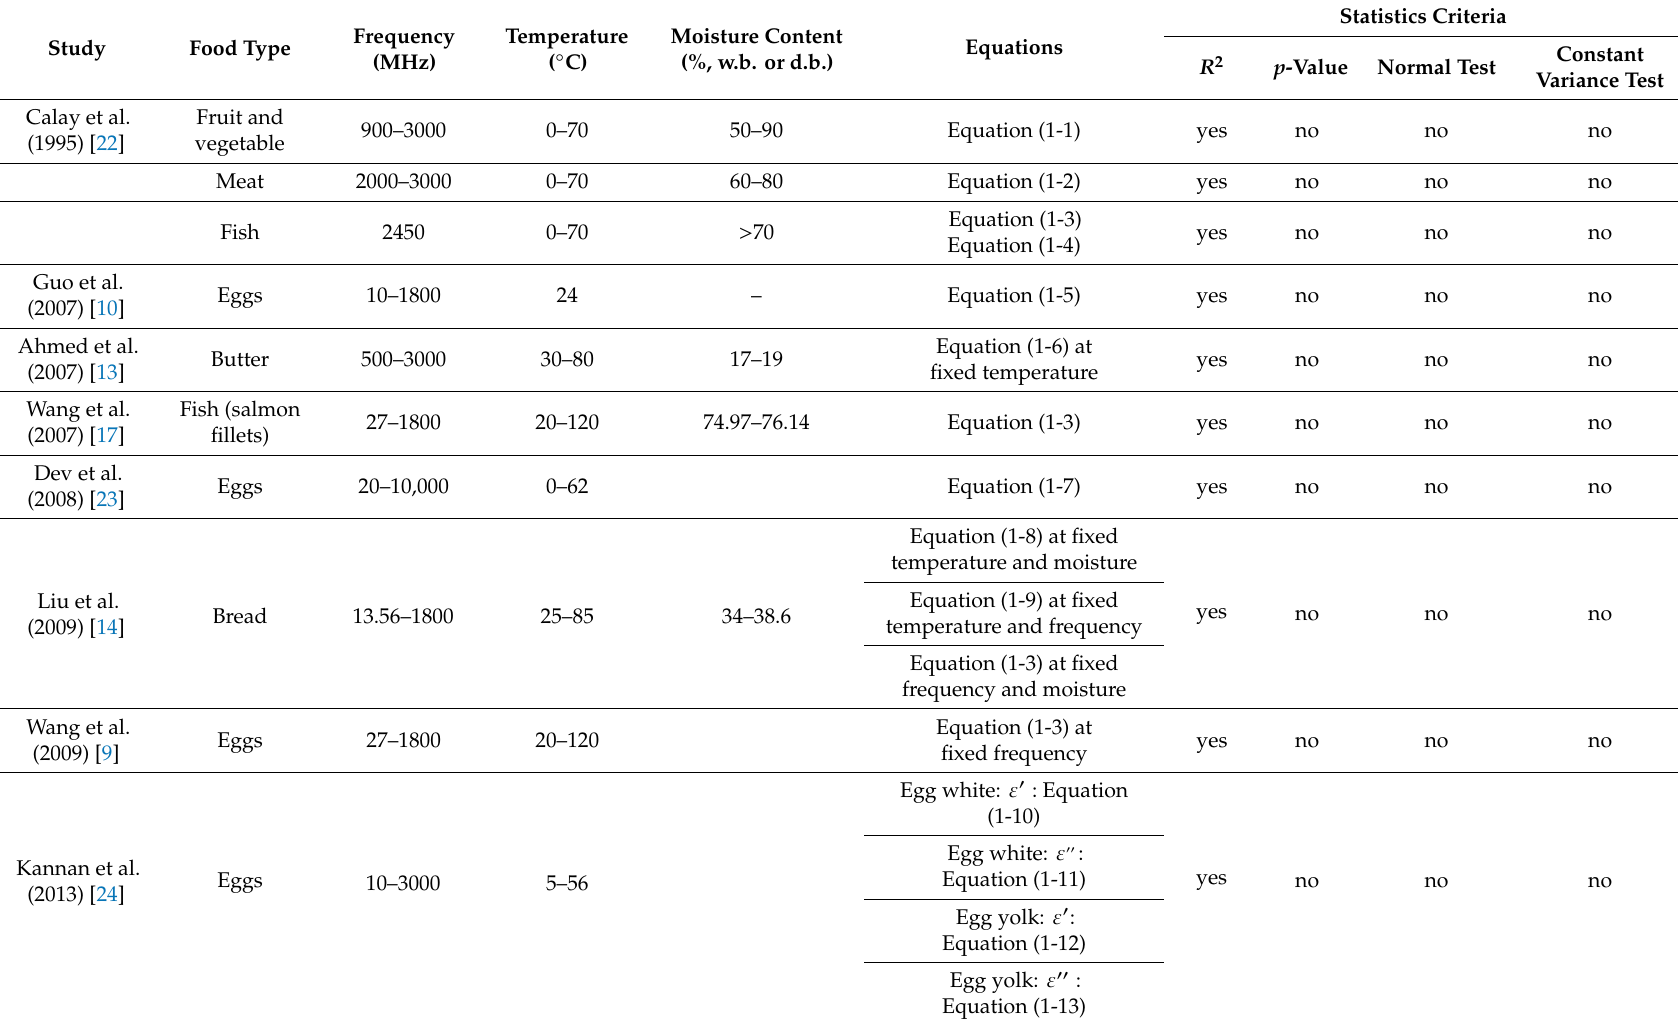
Table 1. Published models of dielectric constants for